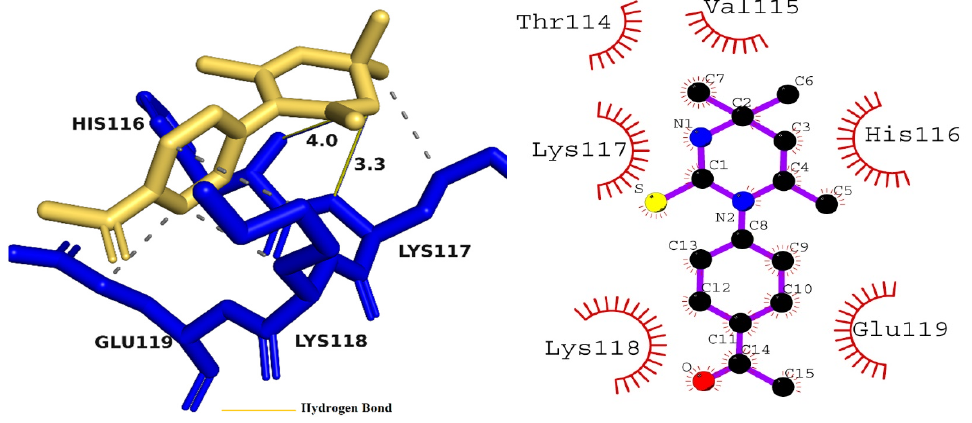
Figure 9. The putative binding mode of compound 4 within the active pocket of mushroom tyrosinase. Compound 4 is represented as yellow lines whereas amino acid residues are represented as blue lines.